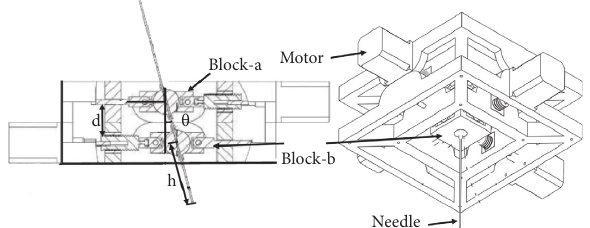
Figure 3: The three-dimensional mechanical structure and sec- tional structure of the surgical robot. It uses two parallel blocks to control the insertion direction and position of the same puncture needle.